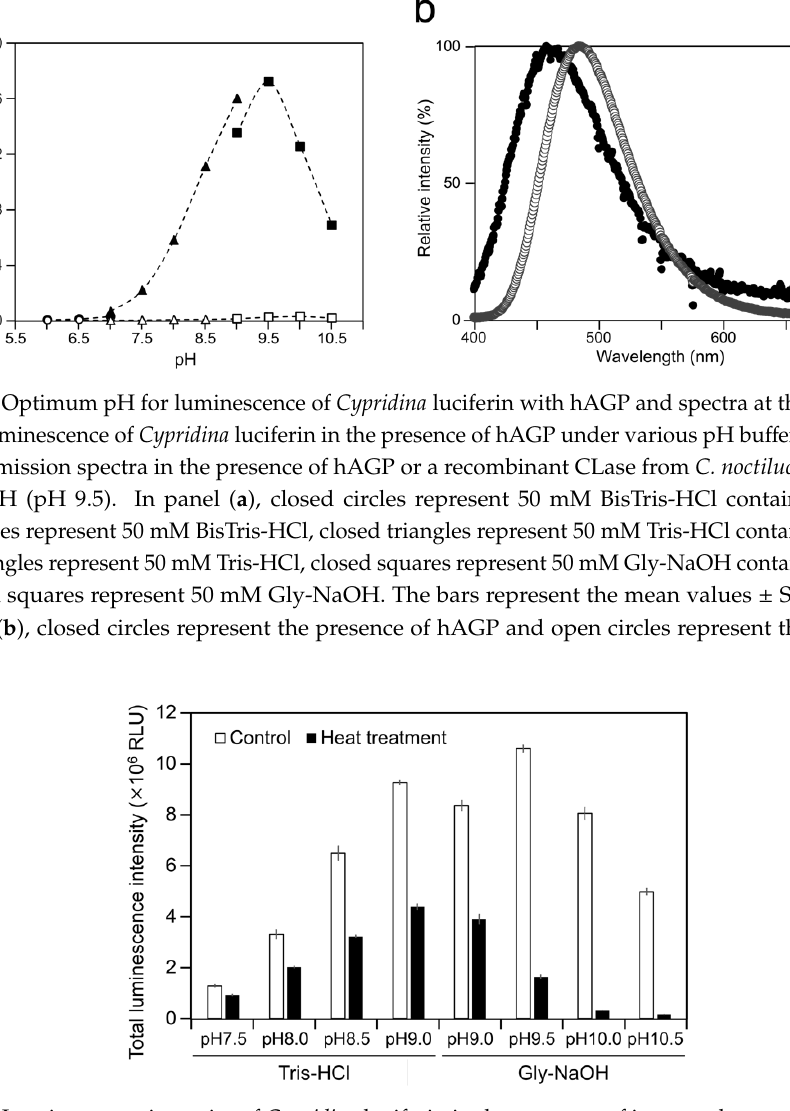
Figure 4. Luminescence intensity of Cypridina luciferin in the presence of intact or heat-treated hAGP under various pH buffer conditions. Control, without heat treatment; heat treatment, heated at 95 °C for 30 min. The bars represent the mean values ± SD for n = 3.